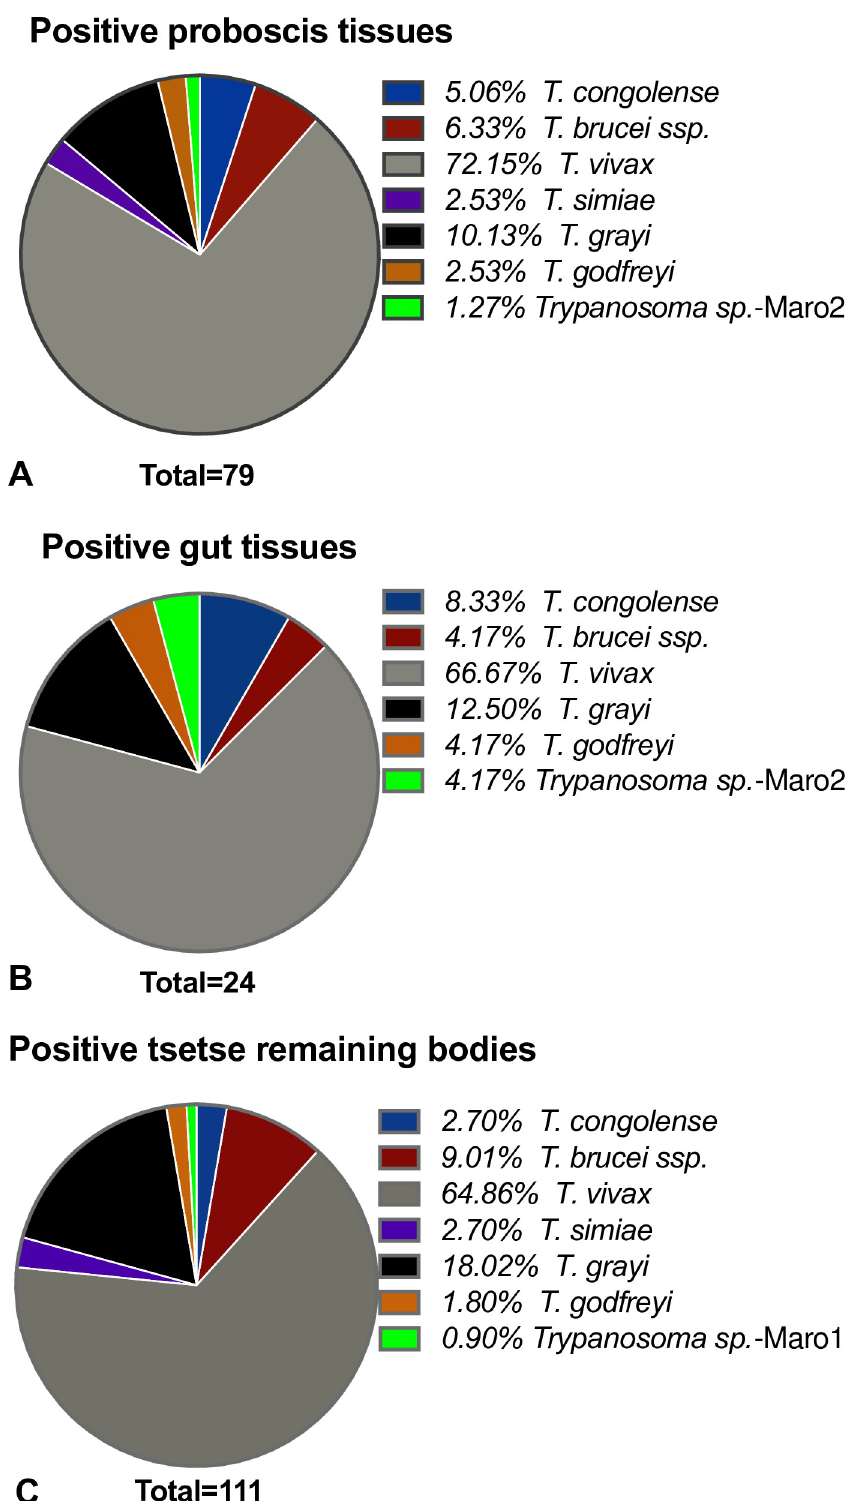
Fig 5. The overall distribution of trypanosomes in positive tsetse fly samples. A - Proboscis tissues; B - Gut tissues; C - Tsetse remaining bodies (TRB).